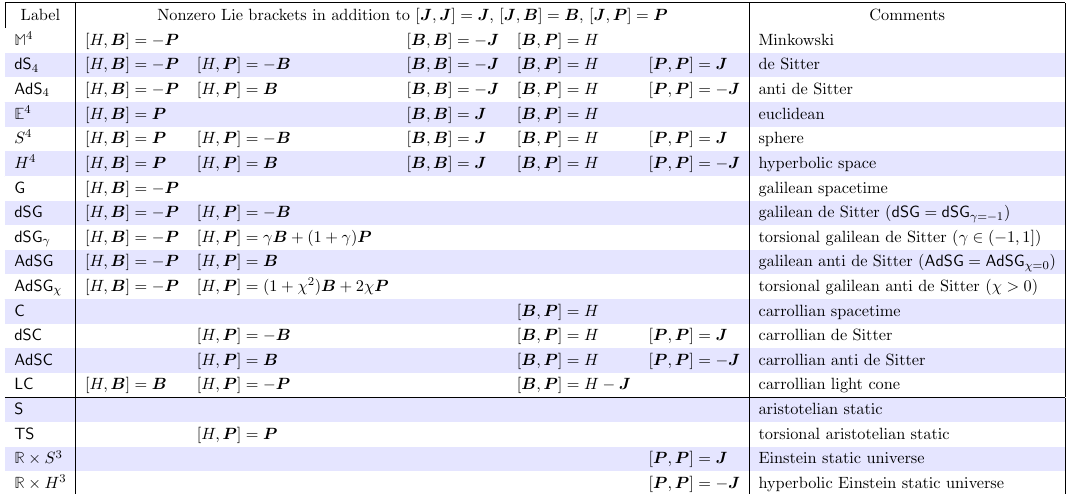
Table 1 . Simply-connected spatially-isotropic homogeneous